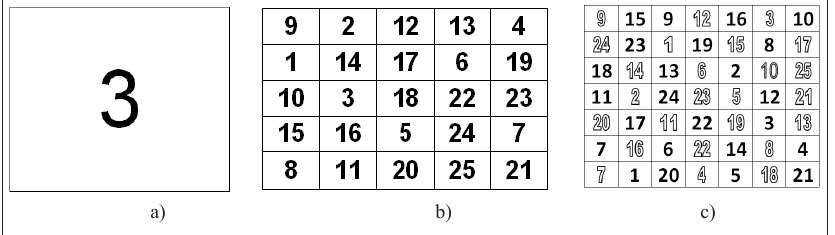
Figure 1. Tests for the assessment of memory characteristics